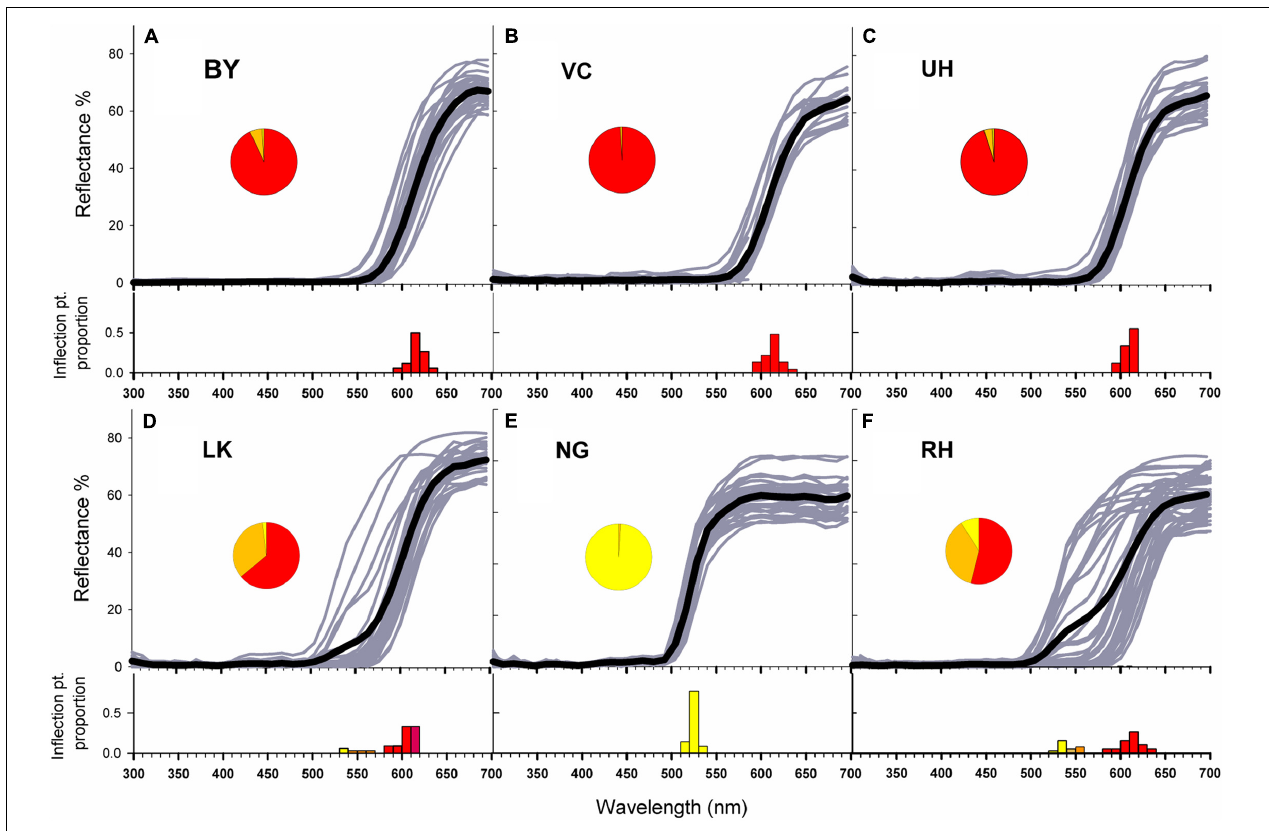
FIGURE 2 | Reflectance spectra between wavelengths of 300 and 700 nm and proportion of inflection points in each 10 nm bin for Gerbera aurantiaca ray florets from the six study populations (A–F) . Darker lines indicate population means. Pie charts show the proportions of yellow, orange and red capitula in each